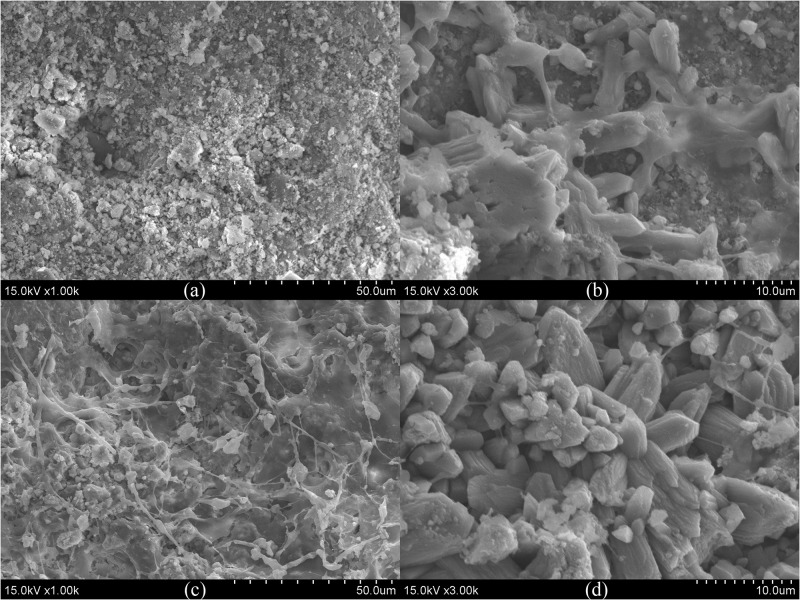
SEM images of the surface of ceramsite granules (a: original ceramsite granule, b–d: ceramsite granules at layers U4, D1 and D2 of CM-A).